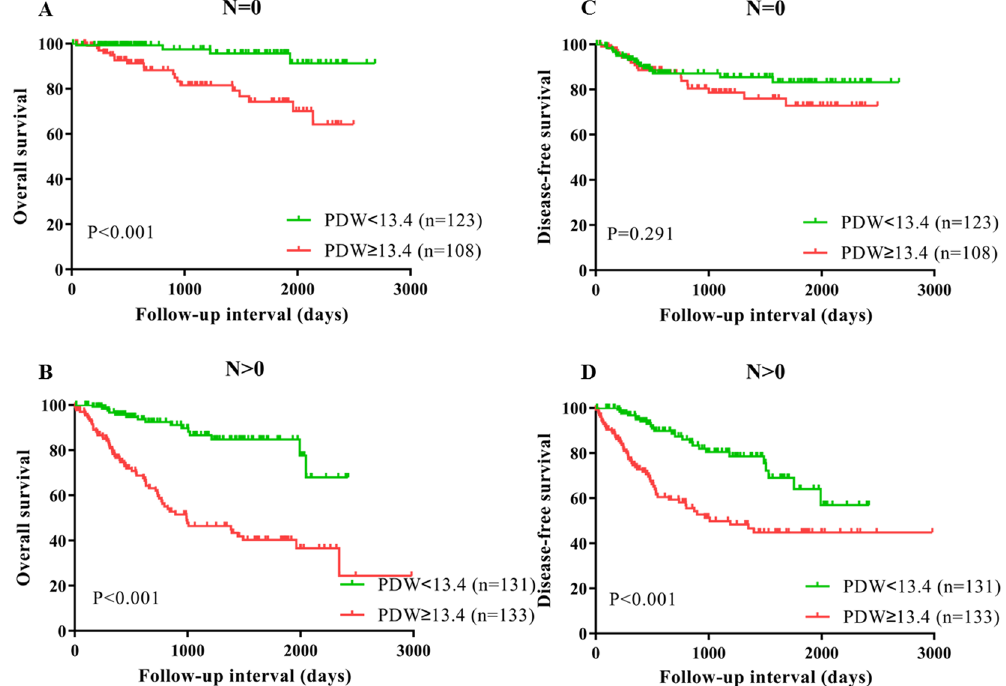
Figure 4. Subgroup analysis based on lymph node metastasis, Kaplan–Meier curves for OS ( A , B ) and DFS ( C,D ), which was stratified according to PDW value (PDW < 13.4 vs. PDW ≥ 13.4) for ESCC patients after surgery. The difference was evaluated by log-rank